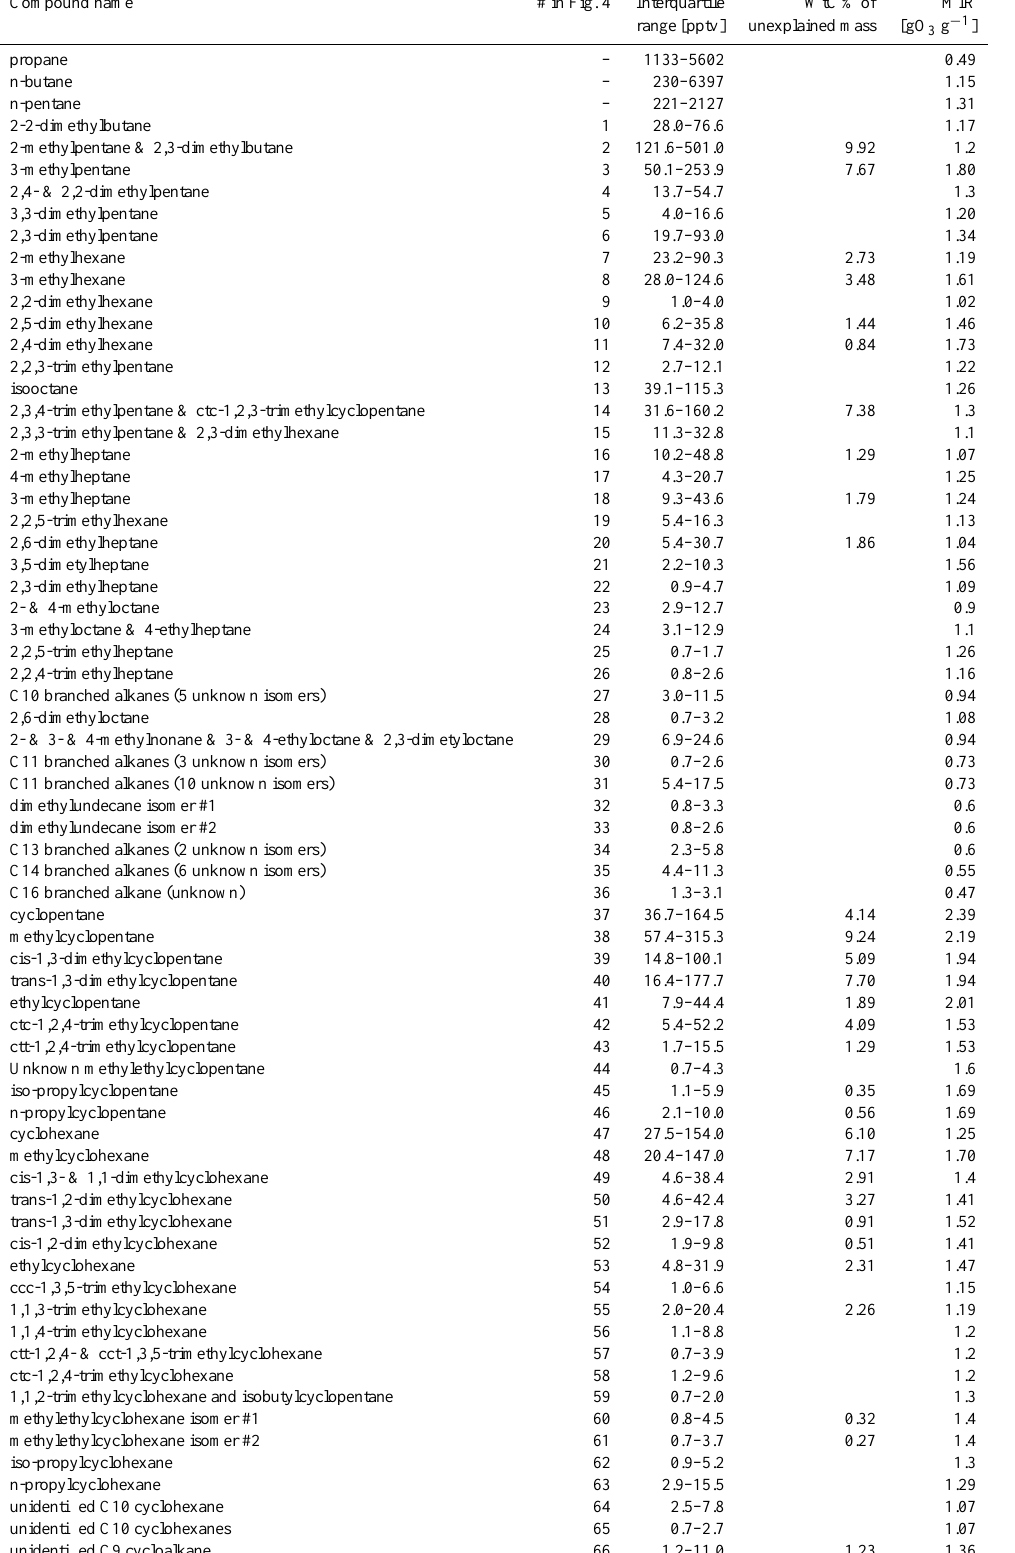
Table 2. Interquartile ranges and MIRs for alkanes discussed in this